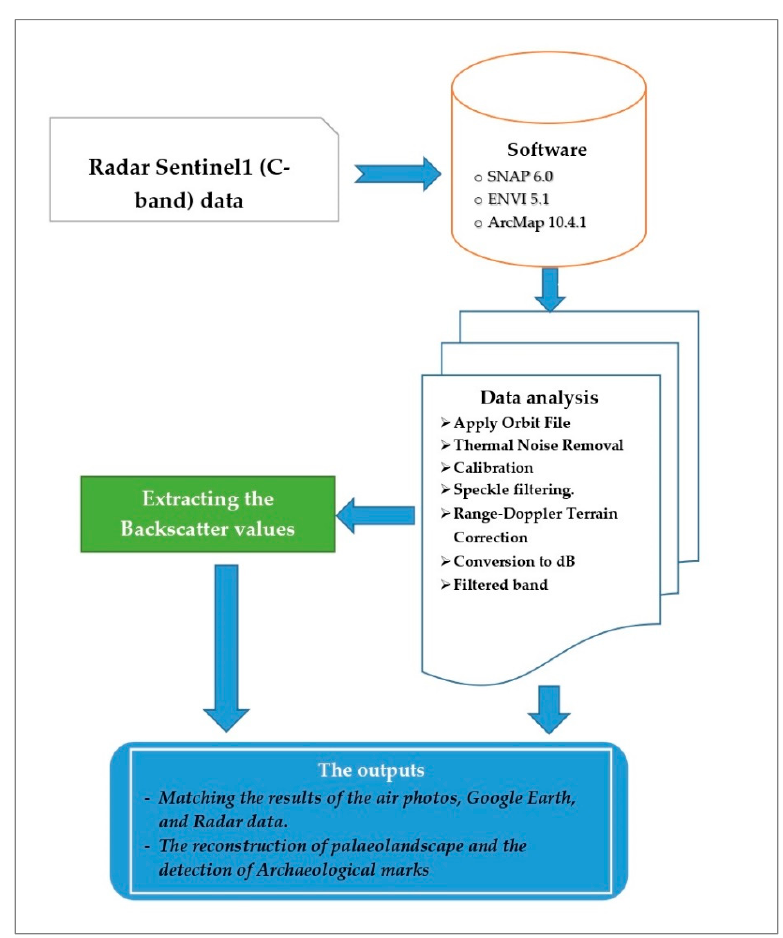
Figure 3. The flowchart of the study, including the data, methods, and the results of the study. Radar S-1A and B satellite images were downloaded from the Sentinel Scientific Data Hub and Alaska Satellite Facility (ASF) data. The pre-processing and processing were done using SNAP 6.0 (Italian National Research Council, Tito Scalo, Potenza, Italy) coupled with tools available in ArcMap 10.4.1 (National Authority for Remote Sensing and Space Sciences, Cairo, Egypt) and ENVI 5.1 software (National Authority for Remote Sensing and Space Sciences, Cairo 1564, Egypt).